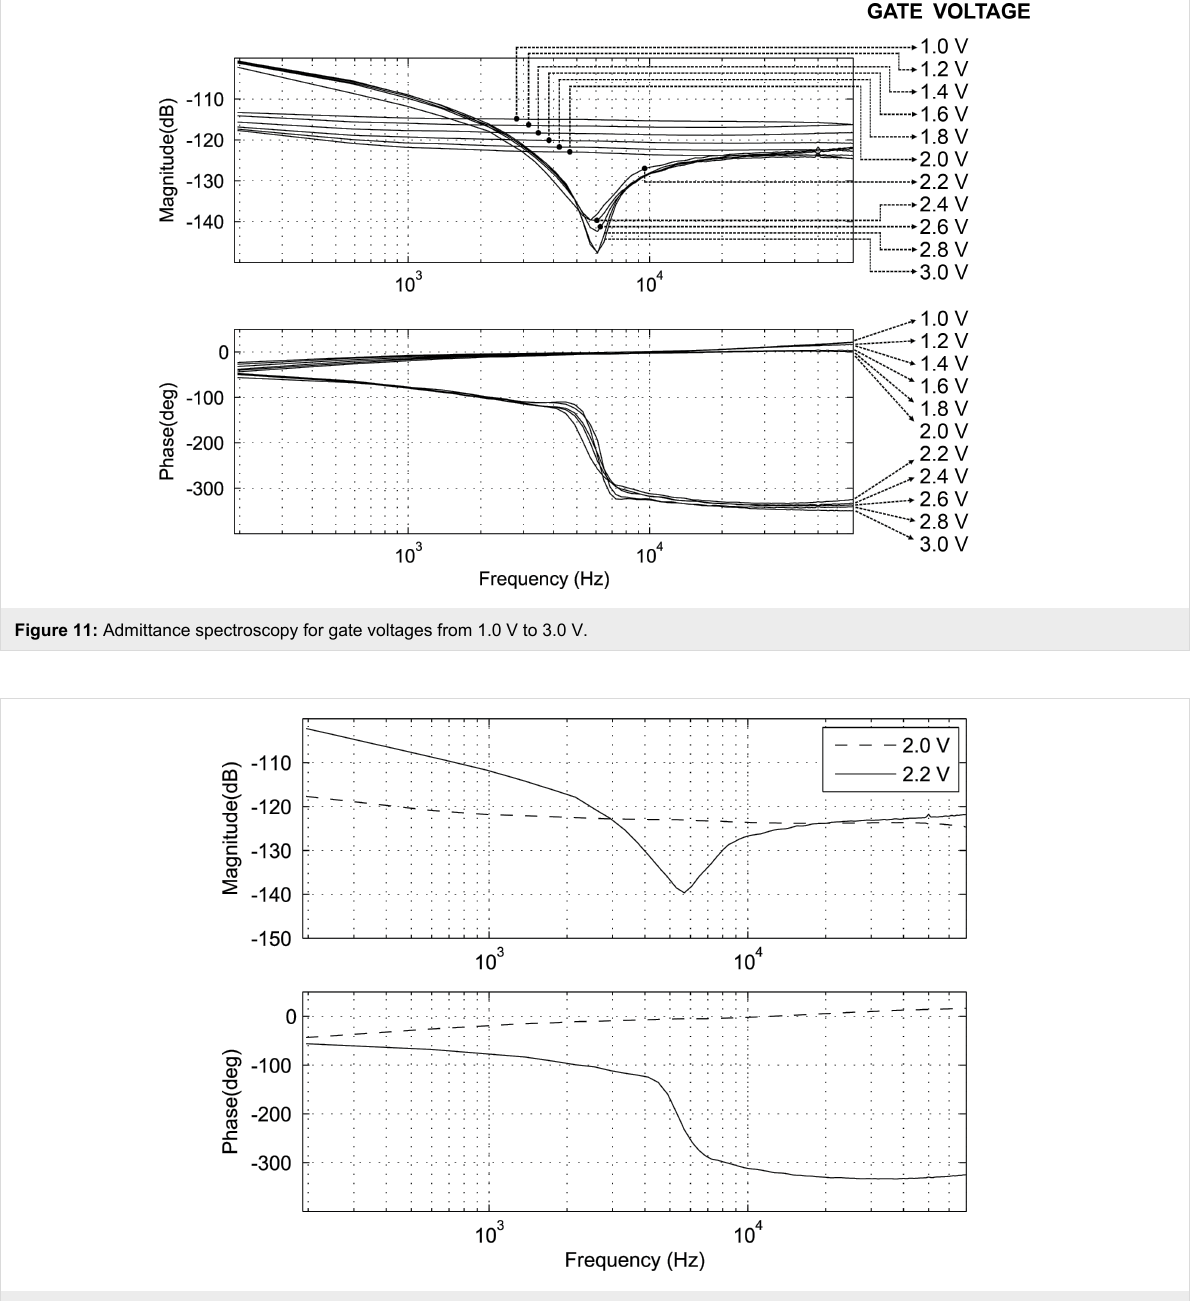
Figure 12: Admittance spectroscopy for gate voltages of 2.0 V and 2.2